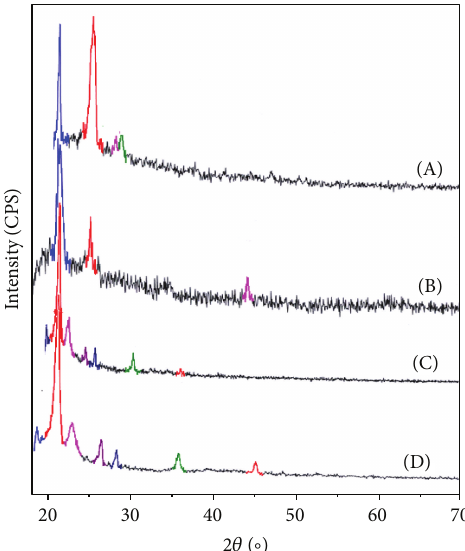
Figure 8: Combined XRD scans of PEO/PMMA/CPMMT/Salt (PPCS1) (2.1wt% A), PEO/PMMA/CPMMT/Salt (PPCS2) (3.5 wt% B), and PEO/PMMA/CPMMT/Salt (PPCS3) (5 wt%